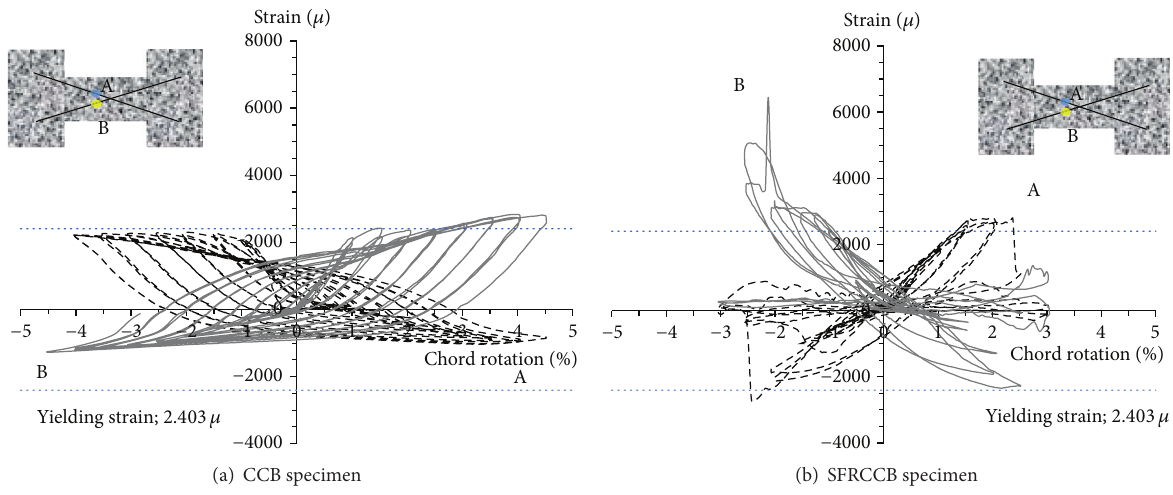
Figure 8: Strain behaviours of diagonal reinforcements in the coupling